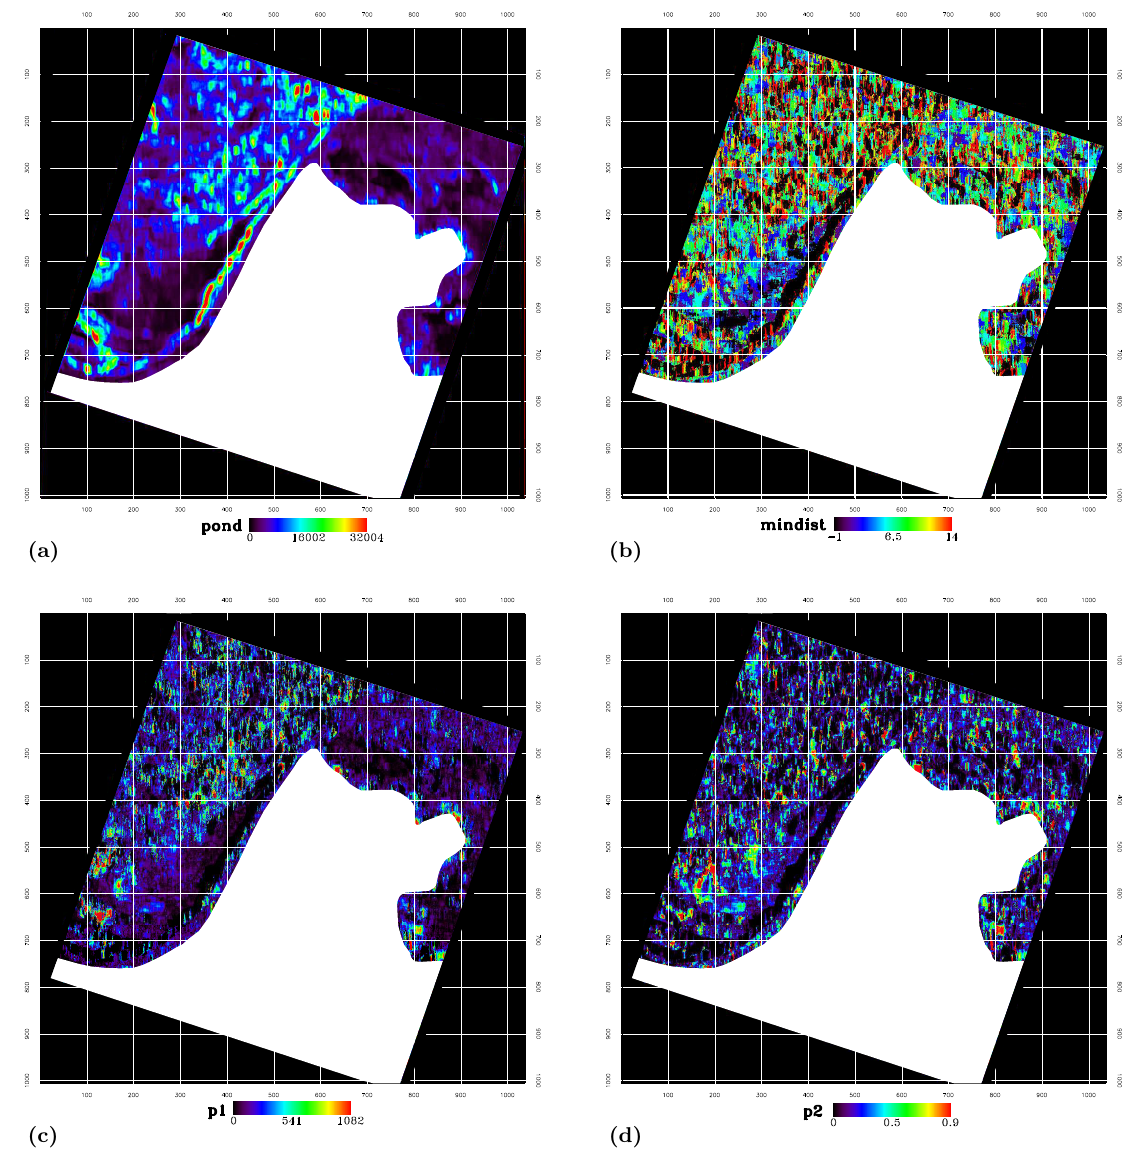
Figure 9. Vario parameter maps derived from ERS-2 SAR data of Barrow area from March 2003 shown in Figure 4—Vario-parameter maps based on first-order directional vario functions in 0 ◦ (E-W) direction calculated for windows of 20 by 20 pixels with offset 1 pixel. ( a ) pond (indicative of overall roughness); ( b ) mindist (showing spacing of dominant features); ( c ) p1 (absolute significance of features); ( d ) p2 (relative significance of features, compared to their